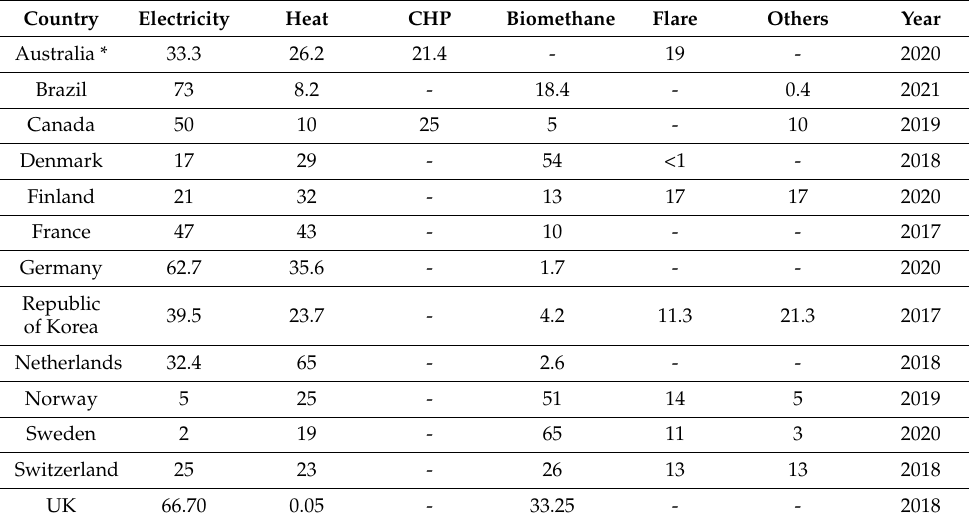
Table 7. Biogas utilisation in some countries from landfills, WWTPs, agricultural, industrial, and bio-waste